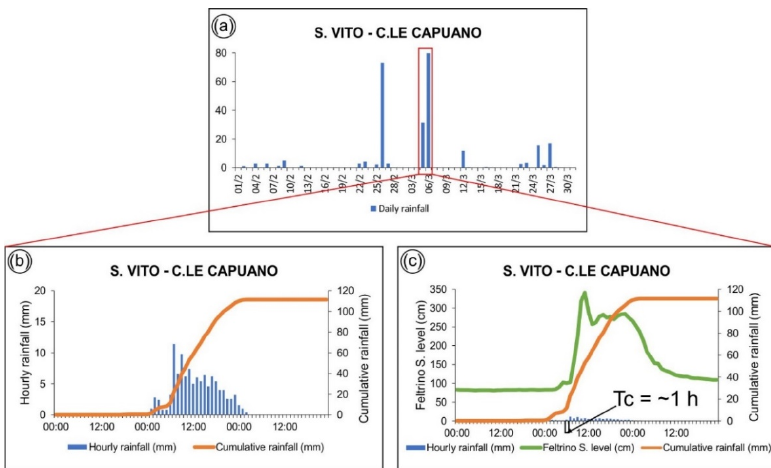
Figure 6. ( a ) Daily rainfall of February–March 2015; ( b ) hourly and cumulative rainfall of 4–6 March 2015 in the S. Vito–C.le Capuano gauge; ( c ) hourly and cumulative rainfall of March 2015 event in the S. Vito–C.le Capuano gauge, the hydrographic level of the Feltrino S. (Feltrino–S. Vito gauge; for the